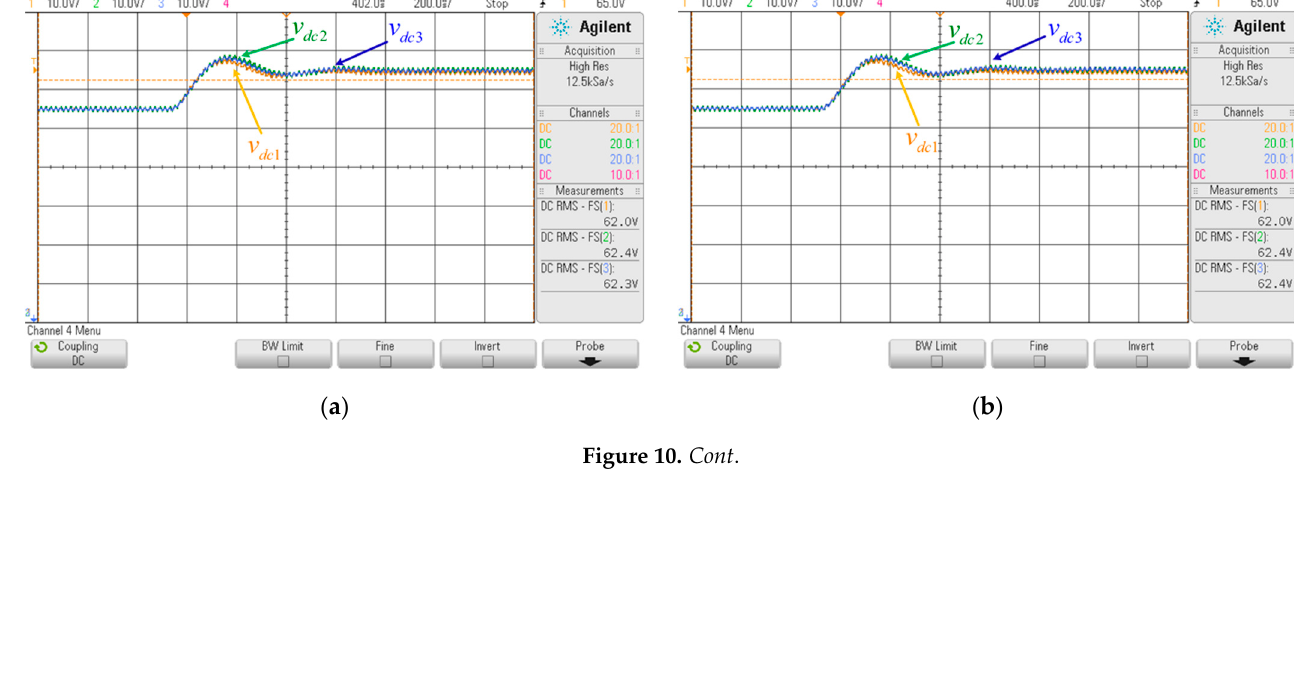
( f ) Figure 10. Experimental results V DC voltage loop. ( a ) Transient response to step change with k sw = 0.00. ( b ) Transient re- sponse to step change with k sw = 0.12. ( c ) Input current change by step change in V DC voltages with k sw = 0.00. ( d ) Input current change by step change in V DC voltages with k sw = 0.12. ( e ) Steady-state V DC voltages with k sw = 0.00. ( f ) Steady-state DC voltages with k sw = 0.12. Author Contributions: Formal analysis, E.E.; funding acquisition, E.E.; methodology, P.M. and C.B.; software, E.E. and J.R.; supervision, J.E.; writing—original draft, E.E. and M.R.; writing—review and editing, E.E., P.M., J.E., J.R. and C.B. All authors have read and agreed to the published version of the manuscript. Funding: The authors would like to thank the Chilean Government for financial support through the research project ANID/FONDECYT/11181203 and FONDAP/SERC/15110019. Institutional Review Board Statement: Not applicable.